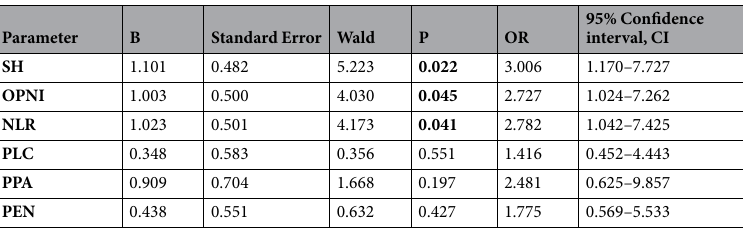
Table 12. Logistic regression analysis of the incidence of postoperative complications. SH , smoking history; PLC , preoperative lymphocyte count; PPA , preoperative prealbumin; PEN , preoperative enteral